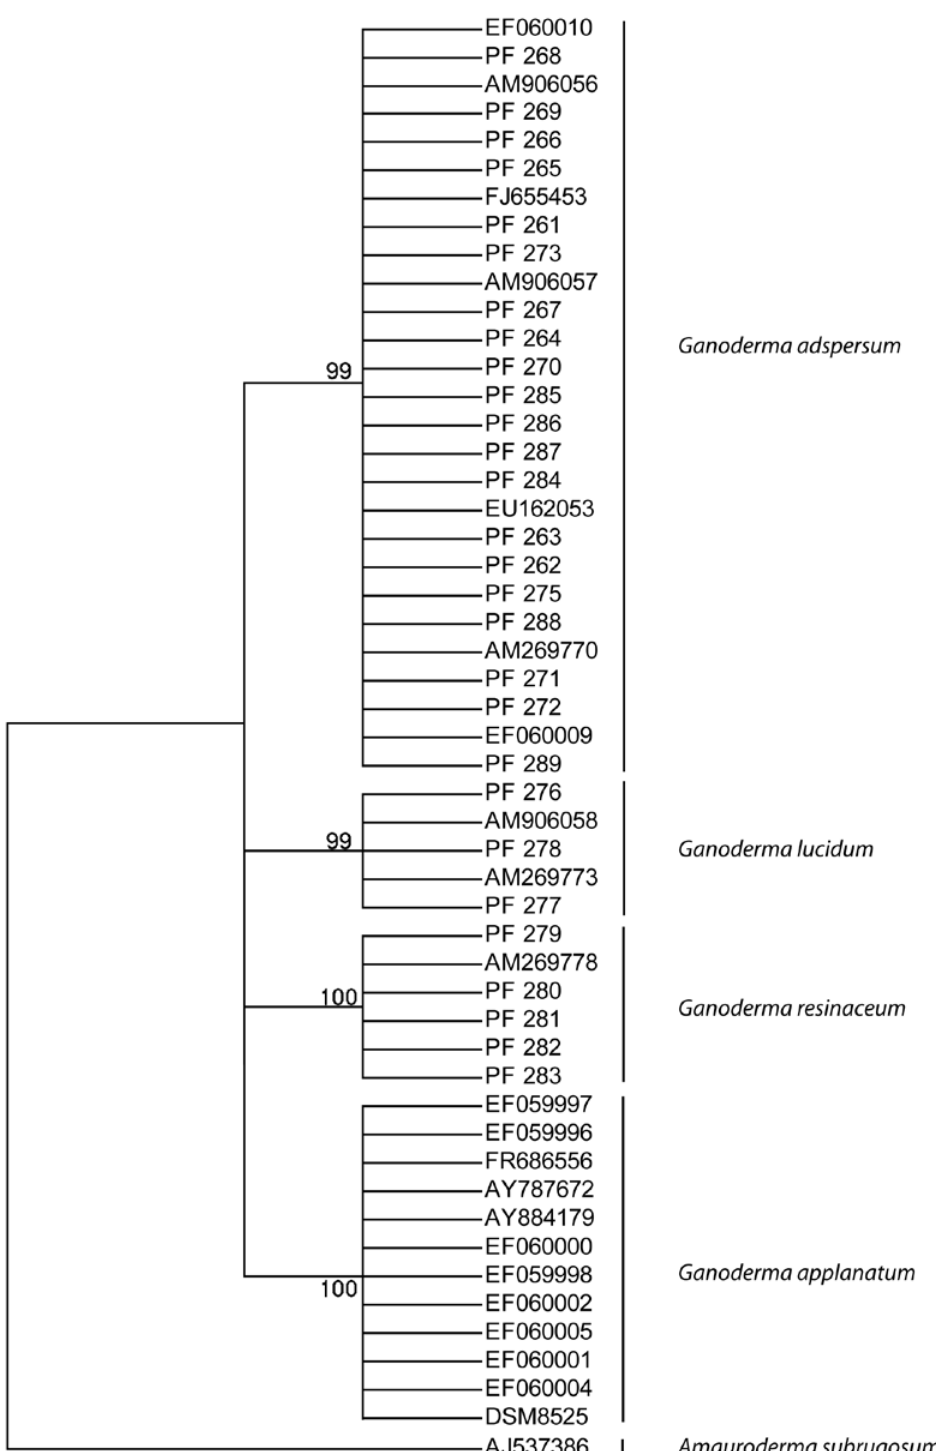
Figure 2. Phylogenetic tree, obtained by maximum parsimony analysis (MP), based on comparison of ITS region sequences of Ganoderma spp. (Tables 1 and 2). Values at nodes are confidence levels (1000